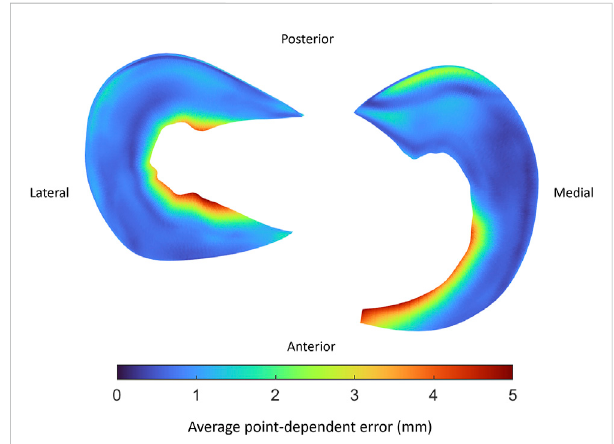
FIGURE 12 Visual representation of the average point-dependent error for themeanpredictedlateral(left)andmedial(right)meniscus.Themean error was color-coded ranging from blue towards red, equaling respectively an average point-dependent error of 0 mm and 5